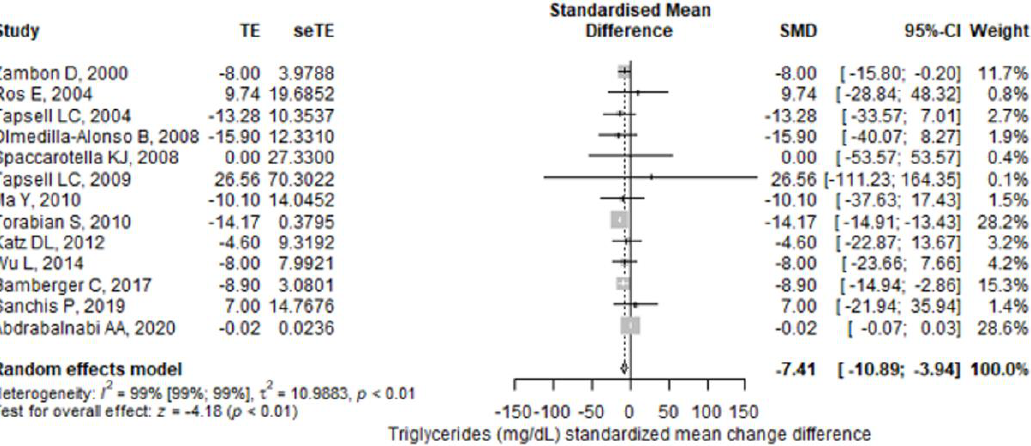
Figure 2. Forest plot for triglycerides (mg/dL) standardized mean change difference. TE — treatment effect; seTE — the standard error of the treatment effect; SMD — standardized mean difference; CI — confidence interval.